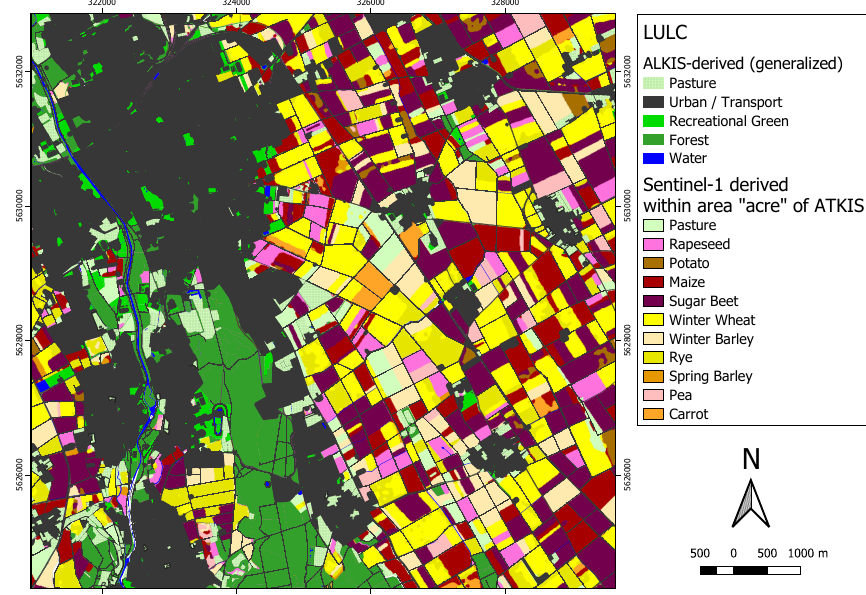
Figure 4. Enhanced land use / land cover (LULC) map by fusing the Sentinel-1 based Crop Classification with generalized ATKIS cadastre